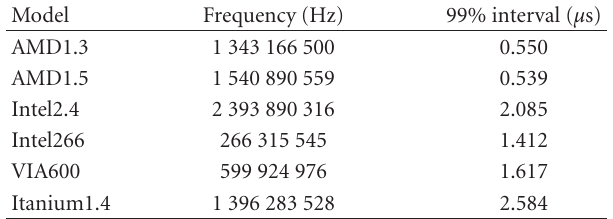
Table 4: Clock frequency for 8 Intel PentiumIV 2.4 GHz micropro- cessors.